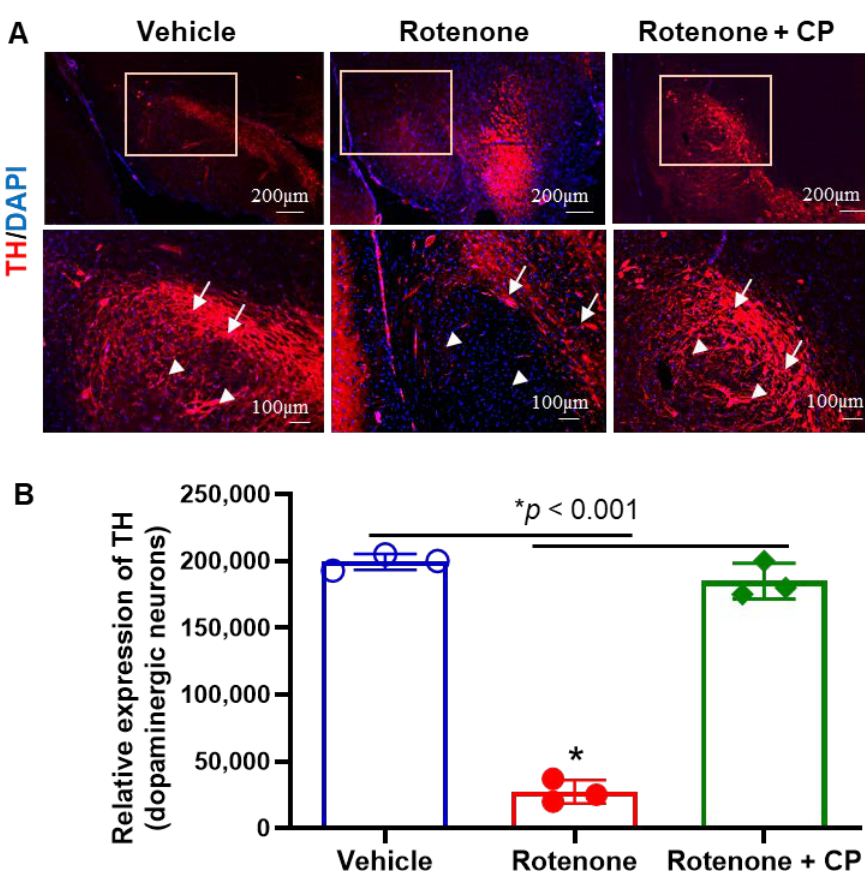
Figure 2. Rotenone-induced distinct loss of SN DA neurons and fibers. ( A ) Immunohistochemistry of rat SN samples with TH (red) following rotenone administration and calpain inhibition by CP treatment. Distinct loss of TH-positive neurons and fibers were seen in the rotenone rats as compared to controls. DAPI (blue) was used for nuclear staining. Note the dense TH staining of neurons in the SNpc (arrows) and DA fibers in SNpr (arrowheads) in the control group and also in rotenone plus CP treatment group. The extensive loss of TH-labeled neurons (arrows) and fibers (arrowheads) was demonstrated after rotenone administration. However, calpeptin treatment (rotenone+ CP) prevented neuronal loss in SN. ( B ) Analysis of TH-immunostained fiber density in SNpr by ImageJ software shows that there was a significant decrease (* p < 0.001) in TH fiber density in rotenone rats, which was prevented by CP treatment. N = 3.